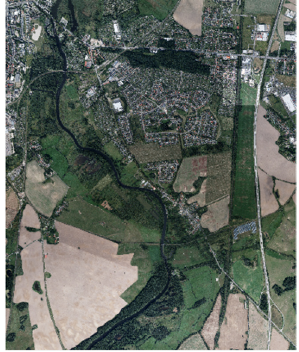
Figure 4. The training and test dataset of Rostock, Germany The data is pre-processed as described in section 2.1,